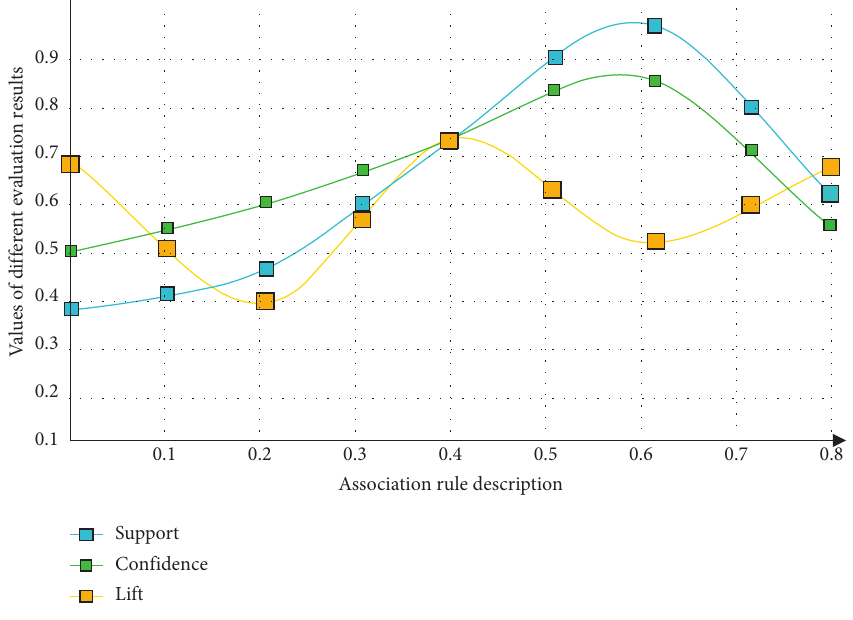
Figure 8: Select data mining results.